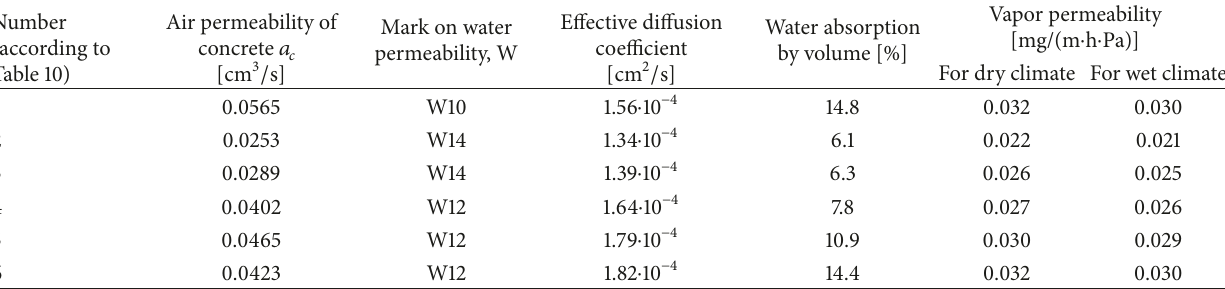
Table 11: The concrete performance characteristics depending on the binder